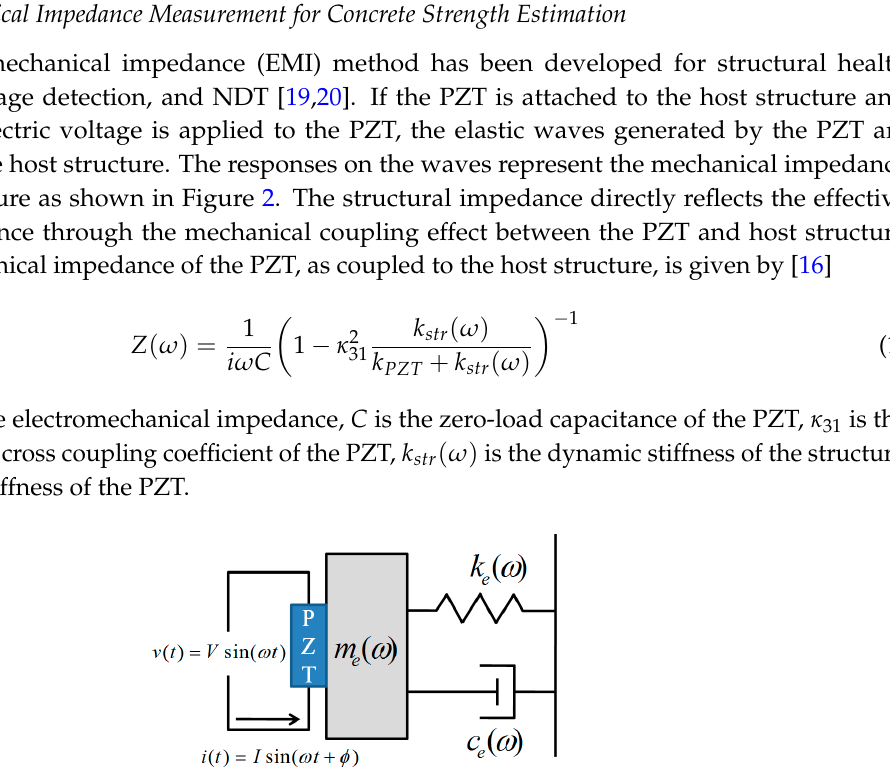
Figure 2. Electromechanical coupling between the lead zirconate titanate (PZT) and the host structure.